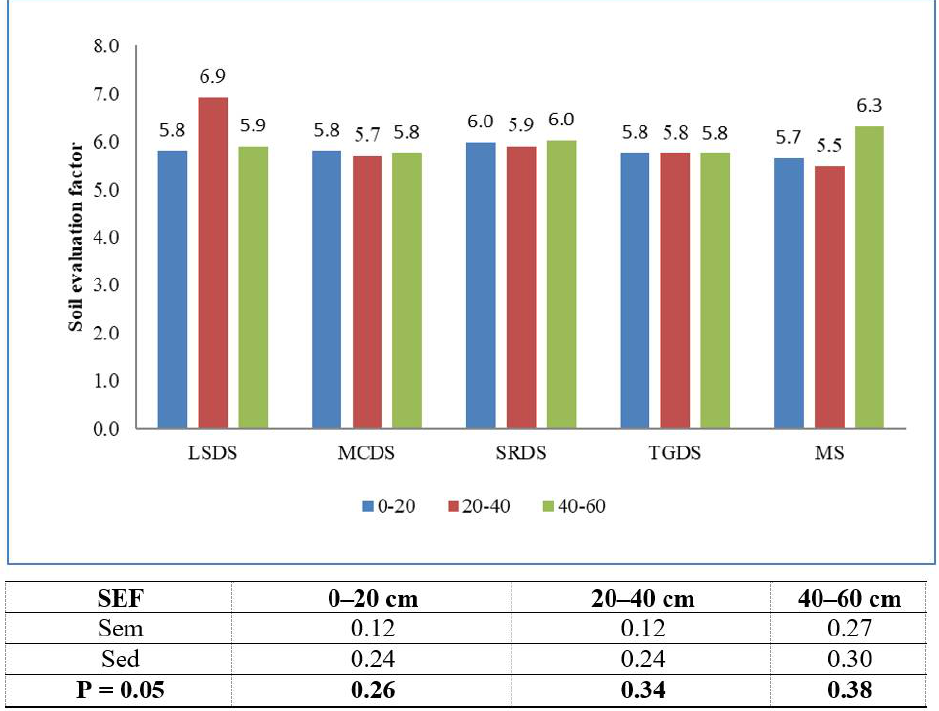
Figure 4. Soil evaluation factor of different stands at different soil depths.